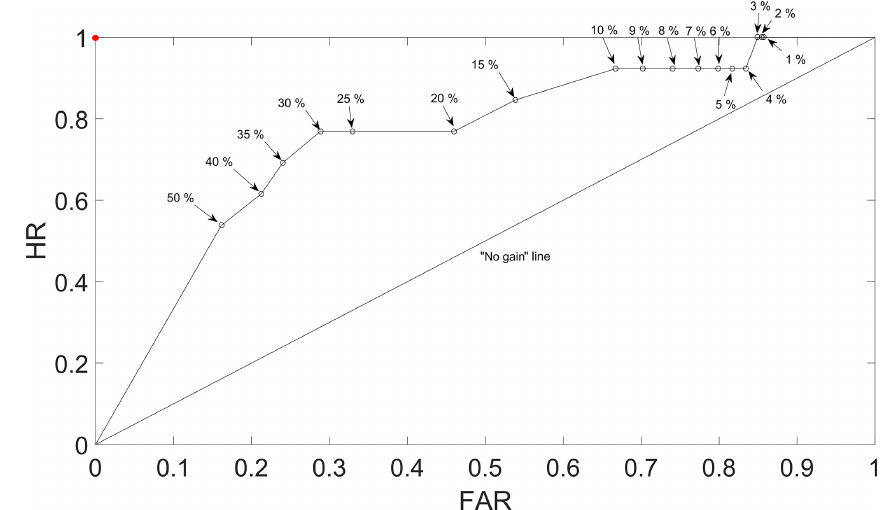
Figure 9. ROC curve for the calculated thresholds using different exceedance probability levels (for Noah-MP at the surface layer). The “no gain” line and the optimal performance point (the red point) are also